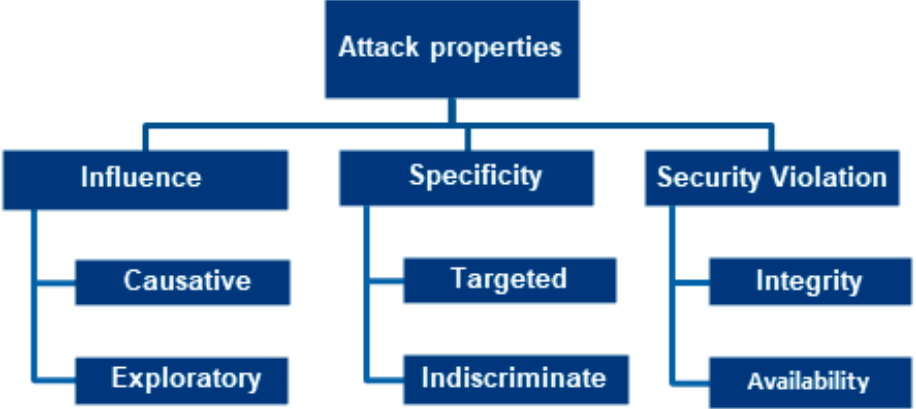
Figure 4. Taxonomy of attack properties on machine learning.